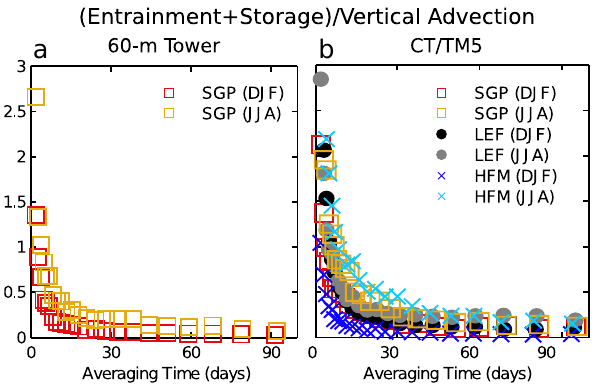
Fig. 2. As in Fig. 1 but for the ratio of the sum of entrainment and storage to vertical advection calculated from 60-m tower and aircraft observations at SGP (a) and from CT/TM5 at SGP, LEF, and HFM (b) .